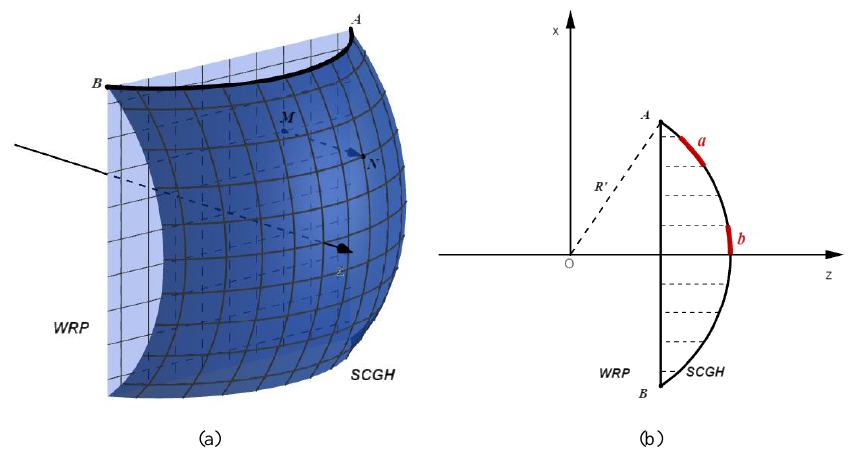
Figure 2. Schematic diagram of nonuniform sampling. Panel ( a ) is the 3D model of sampling, where N is the vertical projection point of M on SCGH; panel ( b ) is the top view of arc AB on the SCGH ( R (cid:48) is the projection on the x-z plane of the radius R of